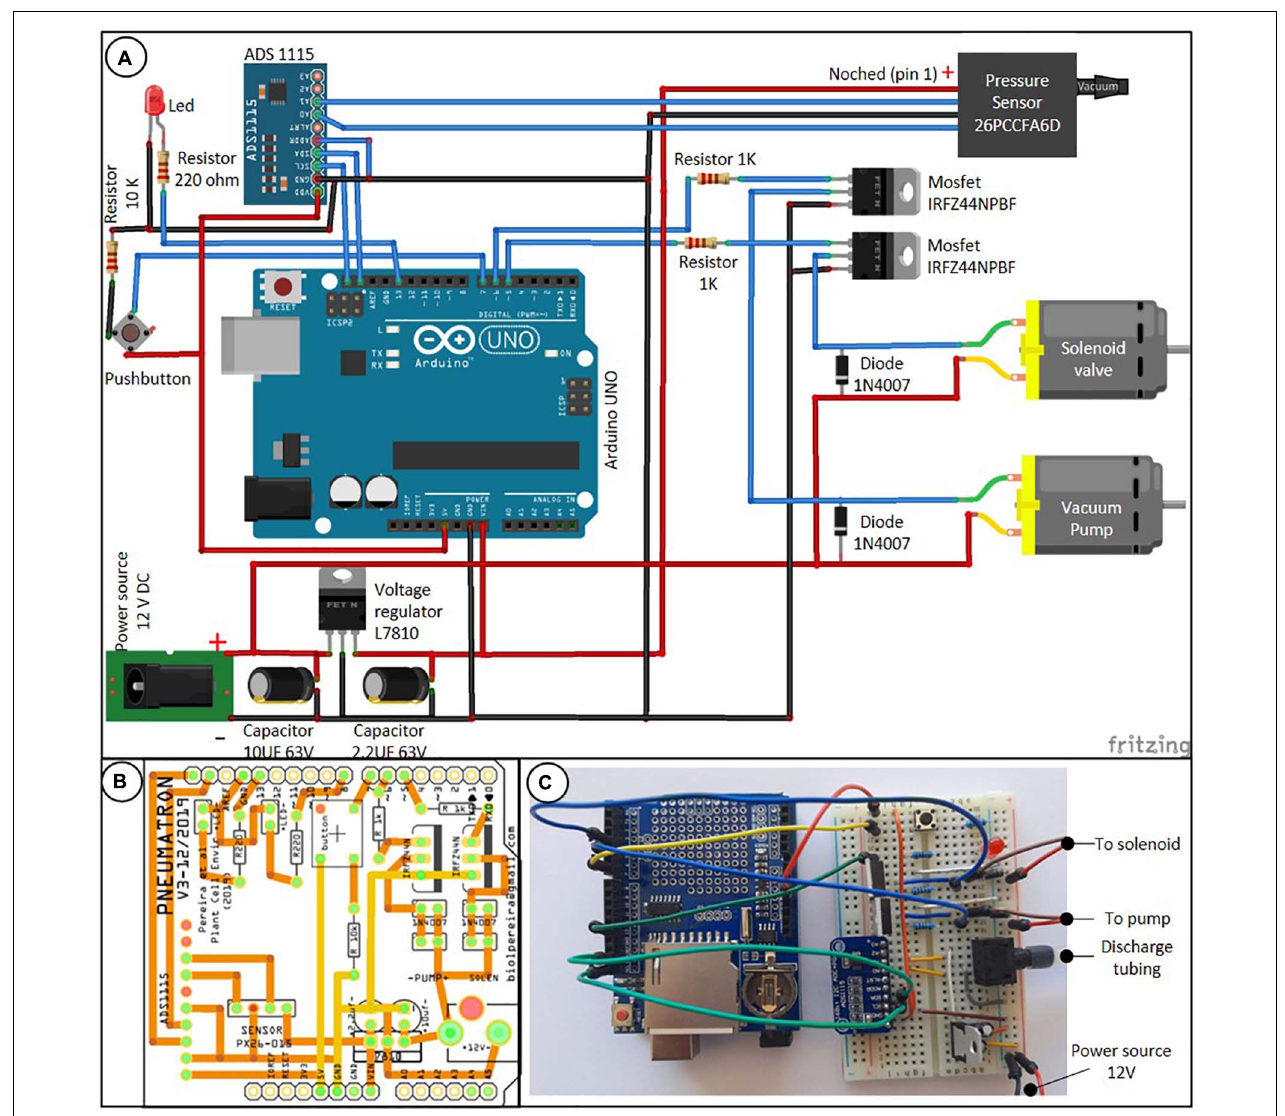
FIGURE 1 | Connection scheme between the Pneumatron components based on wires [ (A) the data logger module, which is connected on top of the Arduino board, is not shown], a two-layer printed circuit board (PCB) of a wireless Pneumatron shield (https://github.com/Pneumatron/construction) (B) , and a non-permanent assembly using a breadboard (C) . The complete list of all components is listed in Supplementary Table 1 and a schematic connection among the parts is presented in Supplementary Figure 1